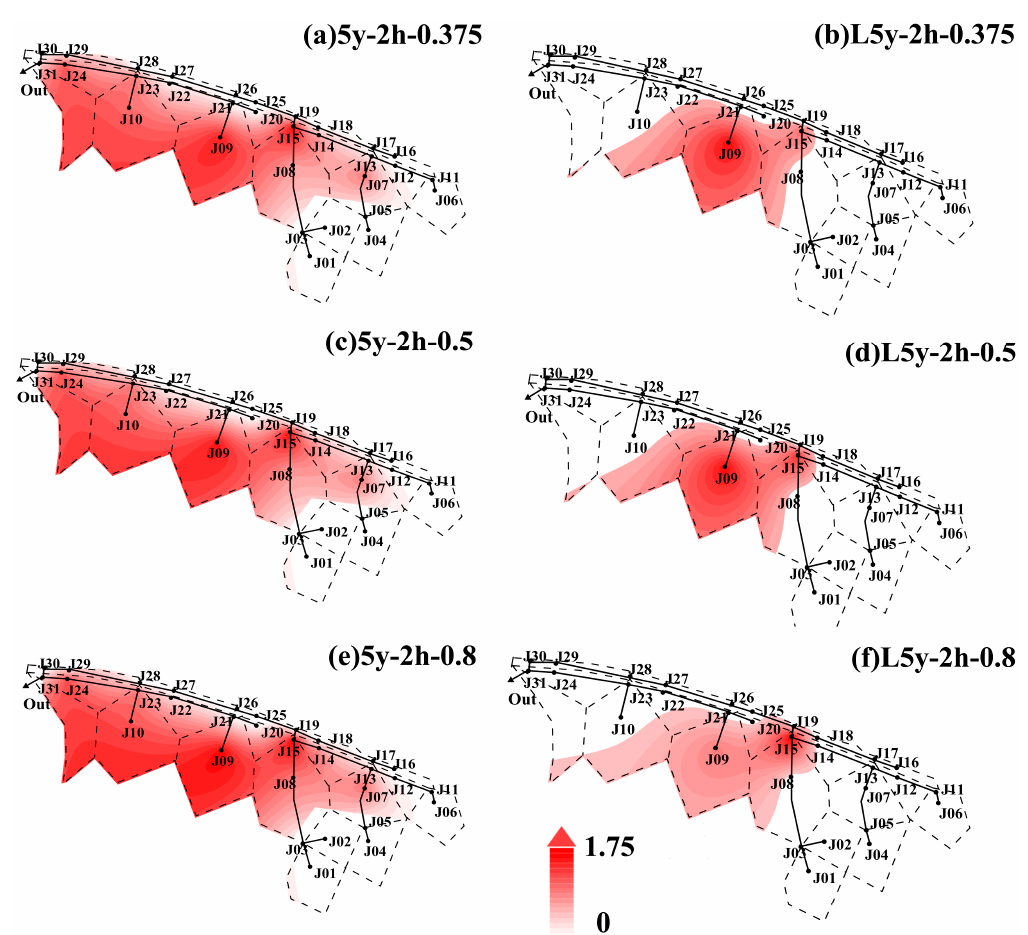
Figure 5. Influence of changes in rainfall peak coefficient on flooding and LID practices. Characteristics of flooding spatial change are reflected by the projection value. ( a , c , e ) show where LID practices are not taken; ( b , d , f ) show where LID practices are taken.